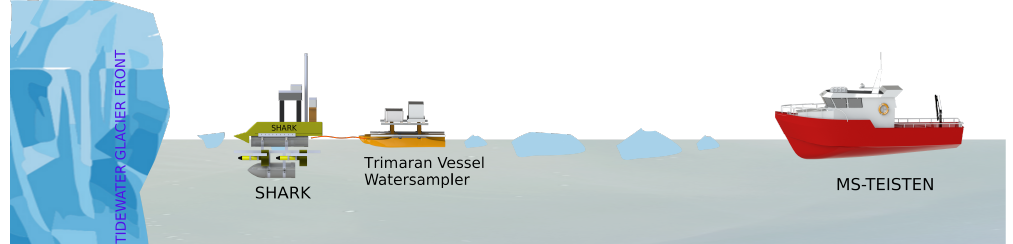
Figure 12. Arctic: Present climatic change and past extreme events (ARCA) project: Shark USSV and towed trimaran (2015).